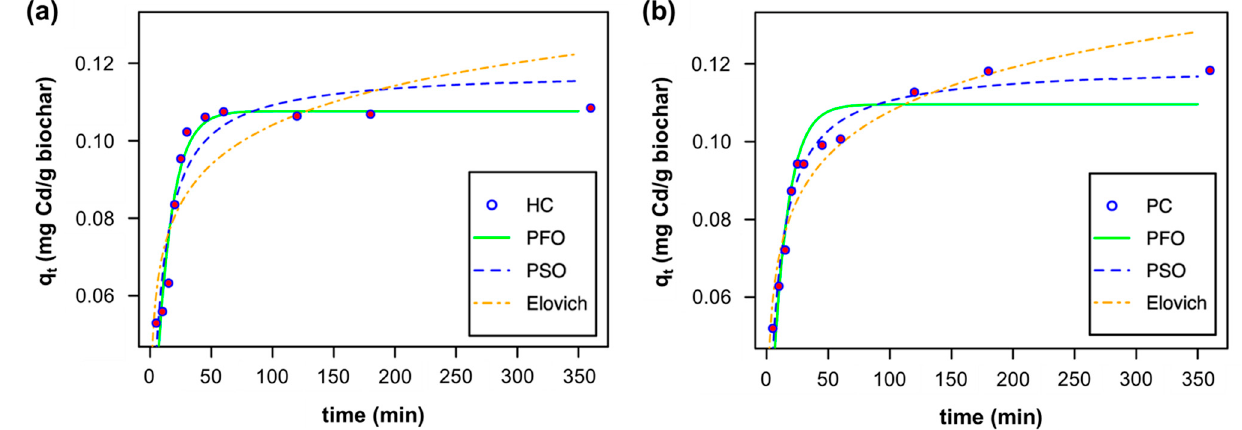
Figure 8. Adsorption Kinetic models of Cd adsorption on ( a ) HC and ( b ) PC.